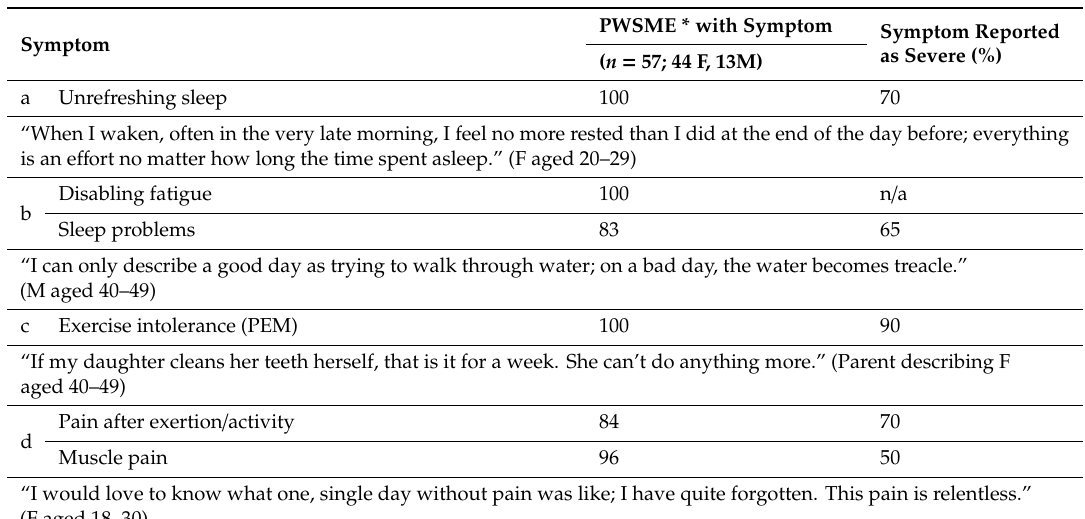
Table 1. Common symptoms a ff ecting people with severe Myalgic Encephalopathy / Chronic Fatigue Syndrome (ME / CFS) seen by